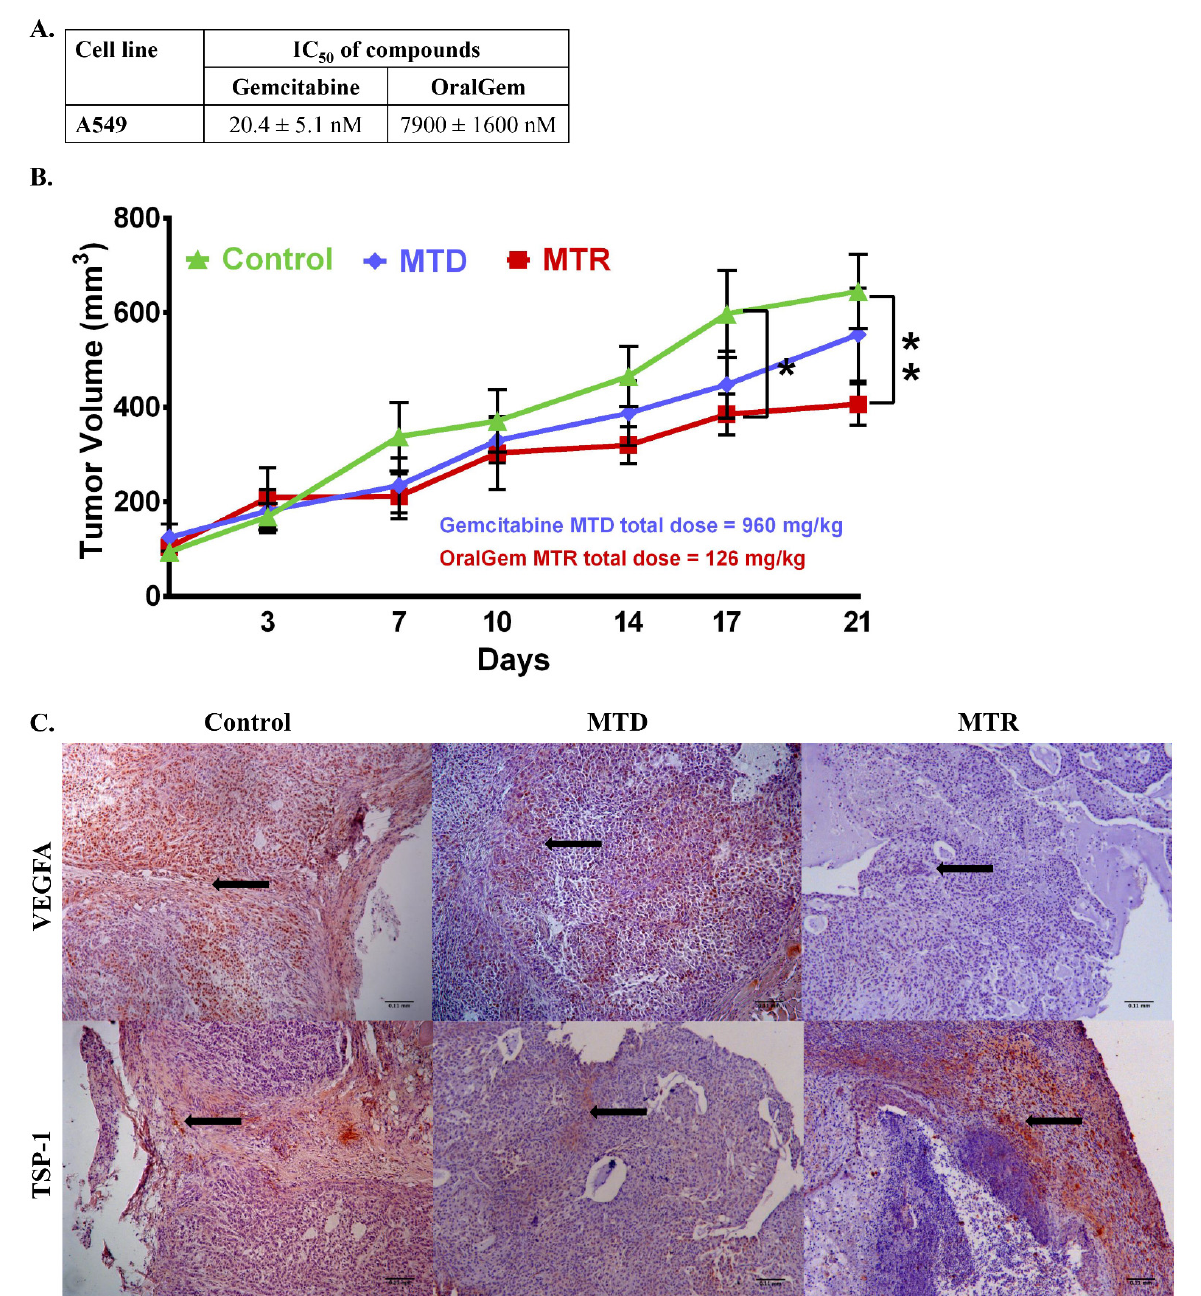
Figure 2. Investigation of efficacious dosing rounds of gemcitabine MTD and OralGem MTR in a xenografted mouse model. ( A ) IC 50 values of gemcitabine and OralGem on A549 cell line. Experiments were performed in triplicates, and statistical analysis was performed via t-test ( n = 3) (set of experiments = 3). ( B ) Efficacy of gemcitabine when administered i.p. at 120 mg/kg for 8 times in 21 days ( n = 6) and of OralGem when administered per os daily at 6 mg/kg for 21 days ( n = 9) in Nonobese diabetic/severe combined immunodeficiency (NOD/SCID) mice xenografted with the non-small cell lung cancer (NSCLC) A549 cell line. The control group ( n = 7) received per os daily 0.5% CMC for 21 days. ( C ) Representative photos of histologic sections of xenograft tissue harvested from the lungs on the day of sacrifice (day 21). Brown color depicts vascular endothelial growth factor A (VEGFA) or thrombospondin-1 (TSP-1) expression. The nuclei staining is depicted in blue (hematoxylin). Representative × 10 fields are shown. Scale bar: 0.11 mm. Statistical analysis was performed by Student’s t -test; * p < 0.05, ** p <